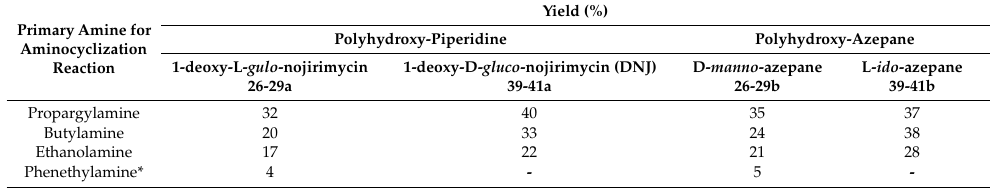
Table 1. Yields obtained from microwave-assisted aminocyclization reaction of bis-epoxides 25 and 35